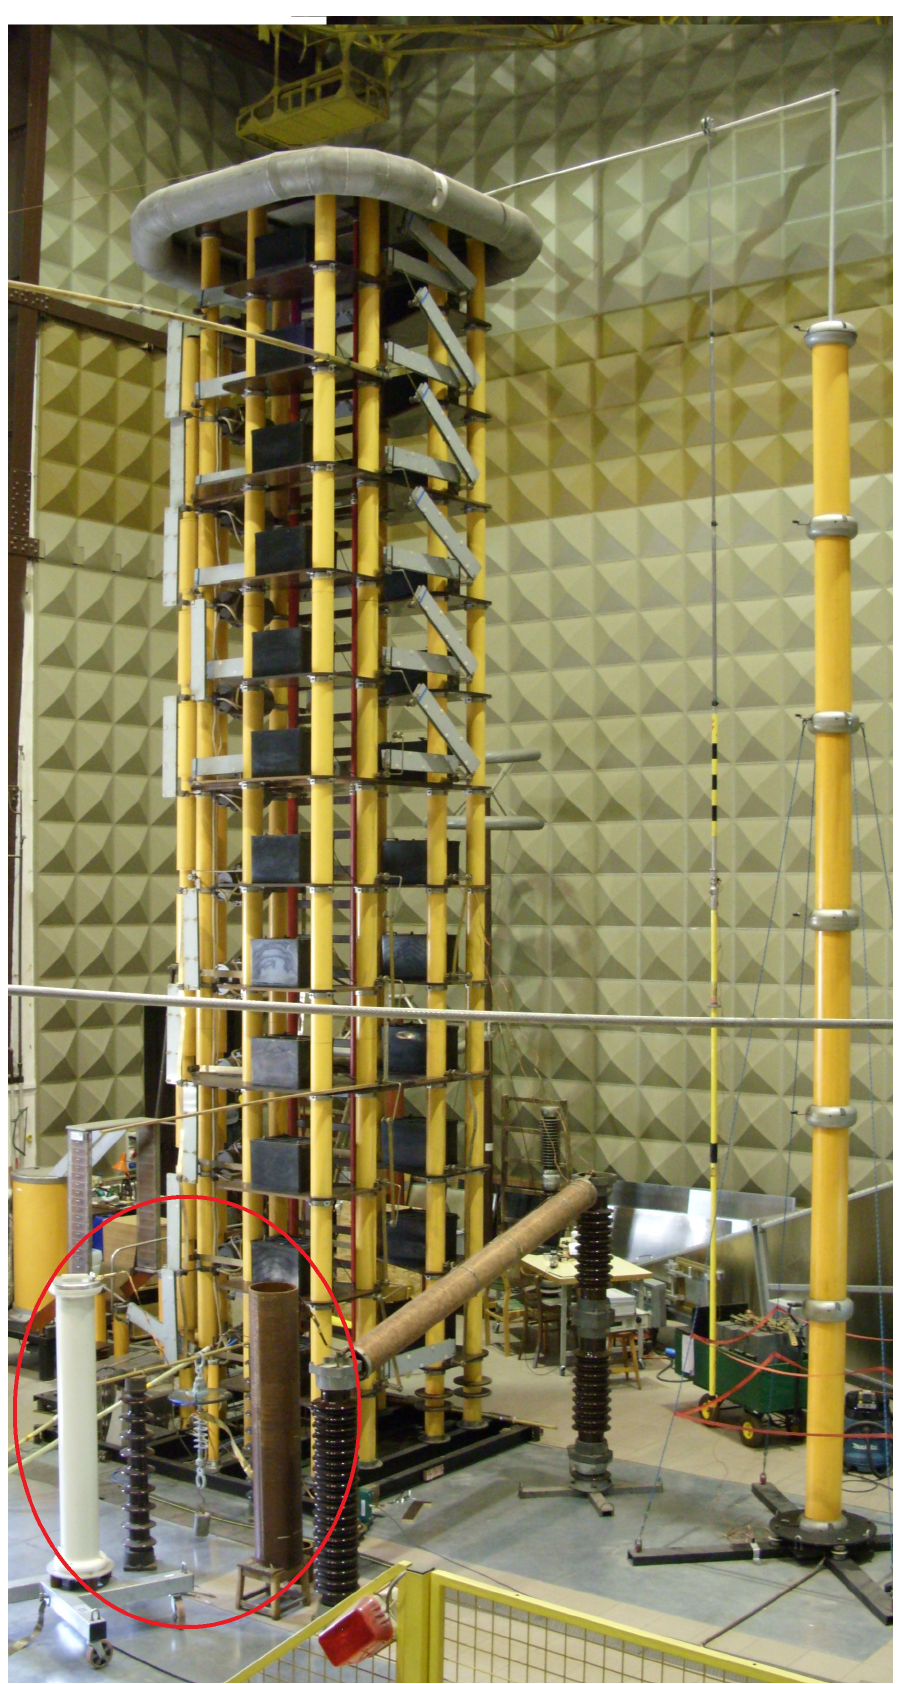
Figure 3. System for testing the MCA device in the area of application of switching